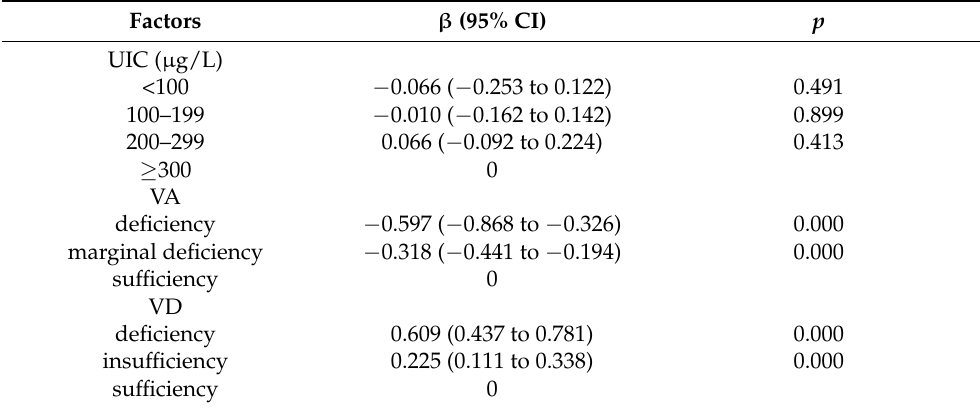
Table 5. Generalized linear model of the association between TSH and UIC, vitamin A/D status.